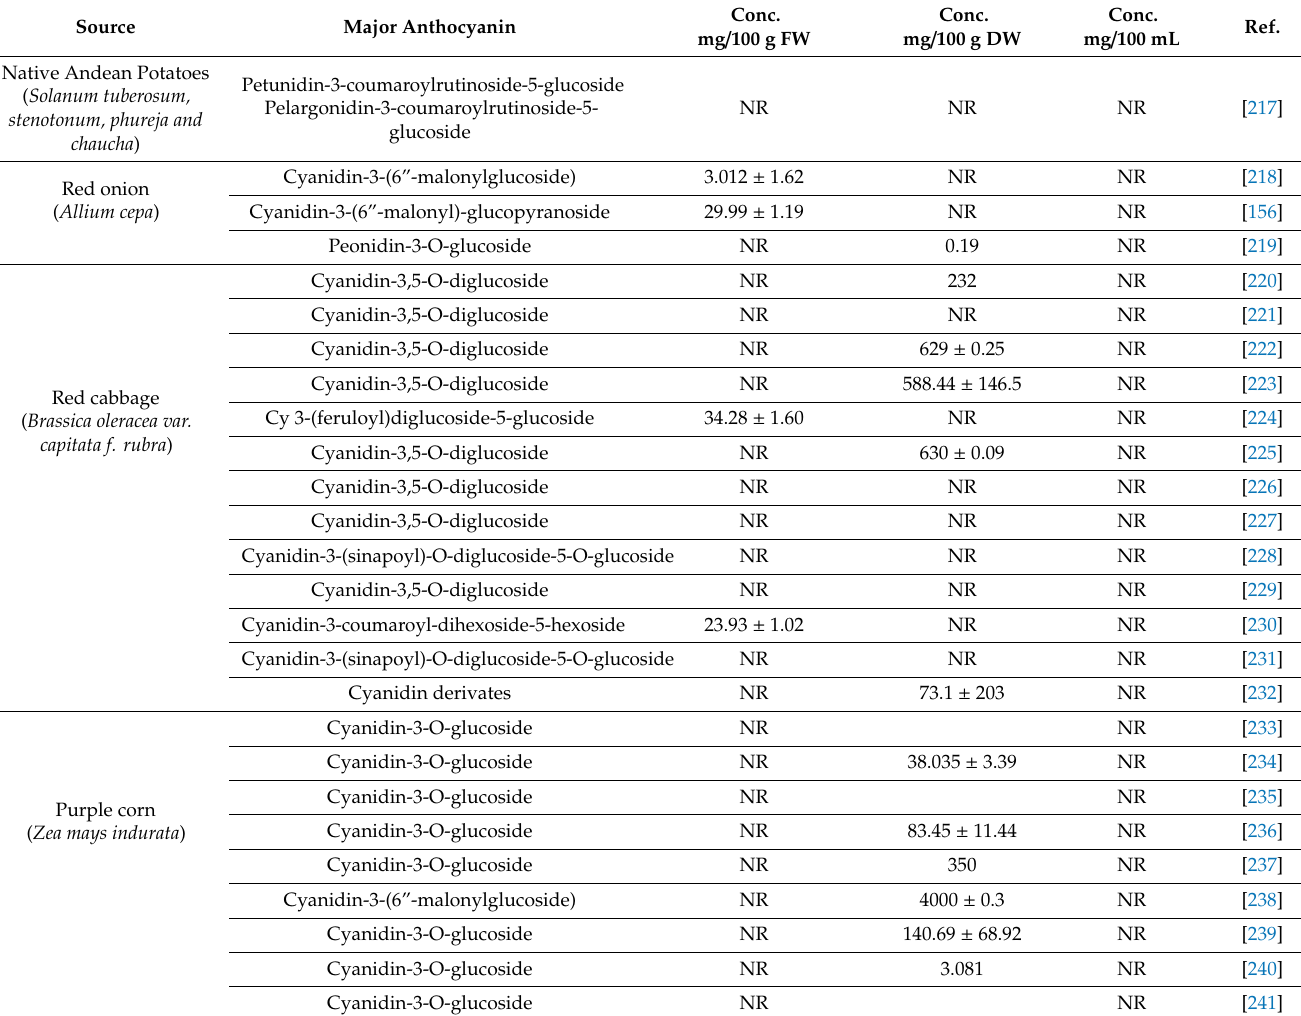
Table 3. Rich anthocyanin sources of